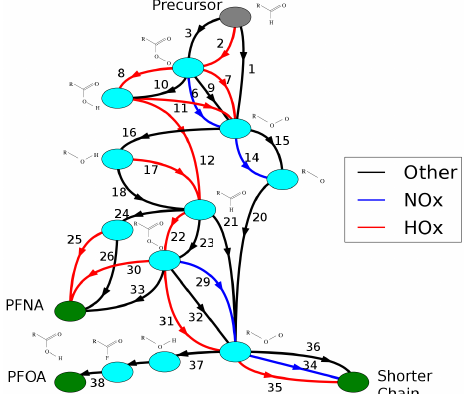
Figure 1. Diagram of reaction mechanism used in box model. Each line represents a reaction, with color of the line indicating the pho- tochemical family of the non-fluorinated reactant. Numbers corre- spond to specific reactions listed in the Appendix.